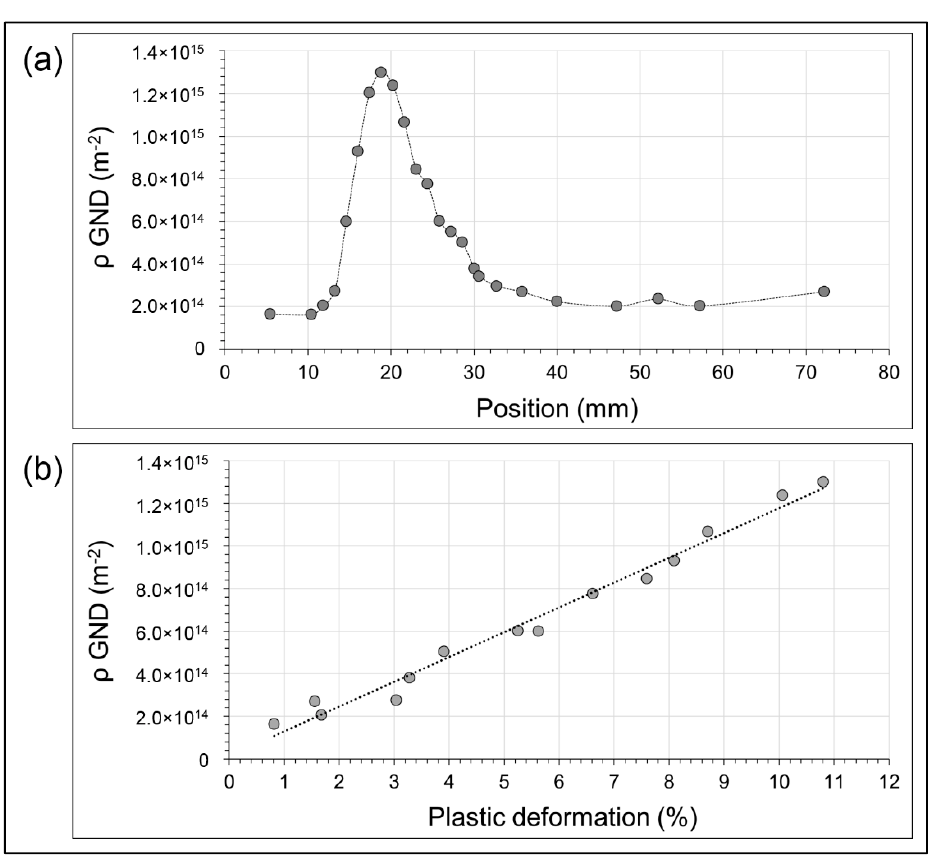
Figure 18. ( a ) GND density along the ( O-y ) axis of the trapezoidal sample for a 6500 N load in the thinnest section (a maximum of 1.3 × 10 15 m − 2 was obtained for 11% local deformation) and ( b ) near-linear dependence between the dislocation density and plastic deformation in the 0–11% range.